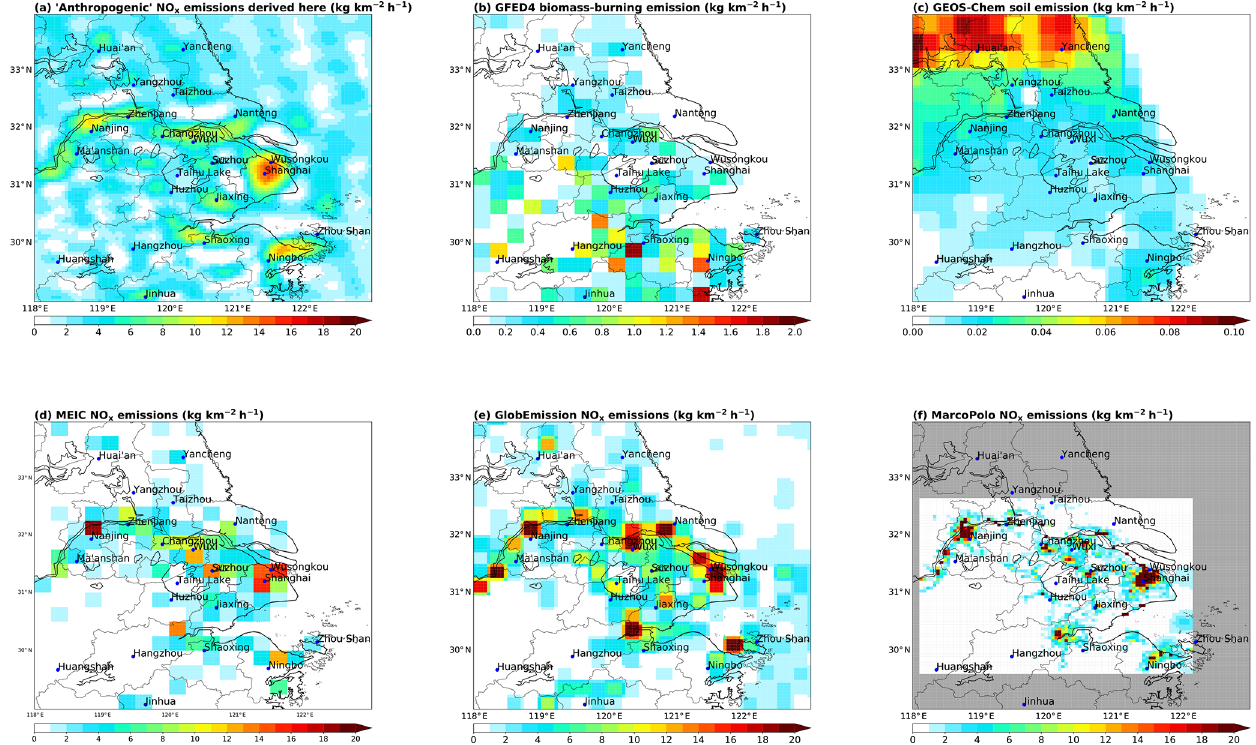
Figure 7. (a) Our “anthropogenic” NO x emissions, by subtracting soil and biomass burning emissions from the derived emissions. (b) GFED4 biomass burning NO x emissions. (c) Soil NO x emissions calculated by a nested GEOS-Chem simulation. (d) MEIC NO x emissions over the summer months of 2012–2015. (e) DECSO v5.1qa top-down emissions in the summer months of 2012–2015. (f) Mar- coPolo bottom-up inventory in summer 2014; note that this inventory does not cover the grid cells shown in grey). All data are regridded to 0 . 05 ◦ × 0 . 05 ◦ .